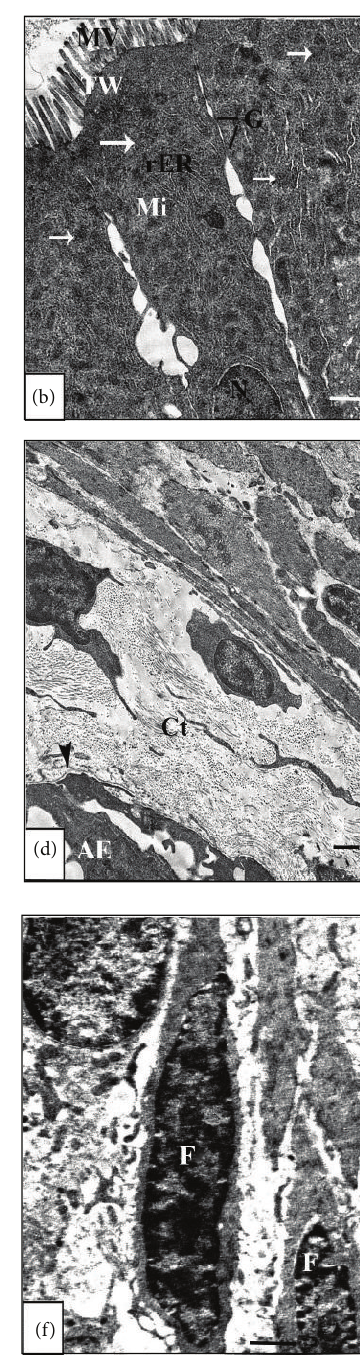
Figure 5: Electron micrographs of the anterior portion of the small intestine of the postmetamorphic stage 66 showing the following. (a): adult intestinal epithelial (AE) cells rest on a thin basal lamina (BL). (b): columnar cells of microvilli (MV) project into the intestinal lumen. A terminal web (TW) can also be seen. The lateral cell borders of two adjacent cells are joined near their apices by a series of desmosomes (D). Mitochondria (Mi) (arrows) and rough endoplasmic reticulum (rER) are present beneath the specialized cell border. (c) and (d): adult epithelium and connective tissue interface. The BL (arrow head) is thin and continuous. (e): adult epithelium and connective tissue interface. The lymphocyte (Lm) in the connective tissue (Ct). (f): an ordinary fibroblast (F) surrounded by collagen fibers in the Ct. Scale bar = 1 𝜇